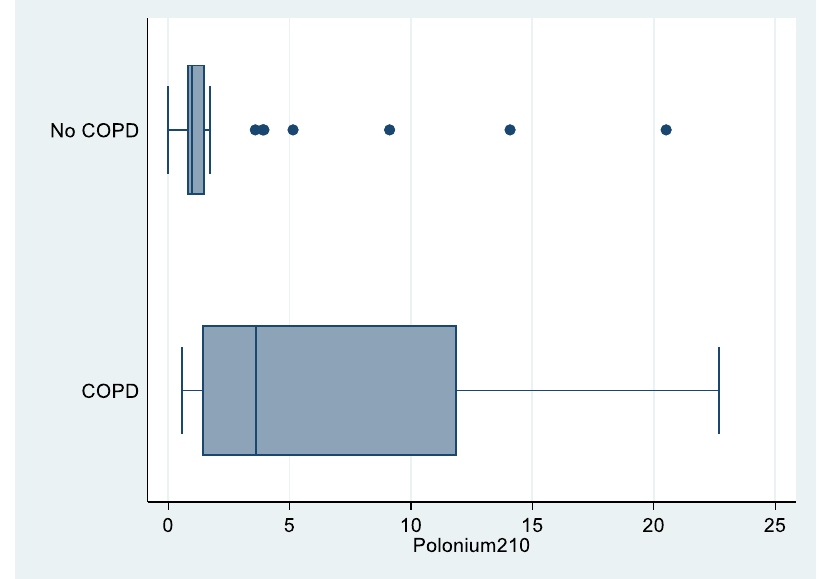
Figure 2. Box plot of polonium-210 (in mBq) by COPD status, “Polonium in vivo” study ( n = 49; 21 missing; COPD n = 12; no COPD n = 37). The left and right borders of the box are the lower and upper quartiles; the solid line in the box is the median. The “whiskers”, that is, the lower and upper adjacent values are used for identifying extreme values in the tails of the distribution. Dots greater than the upper adjacent value, represent outliers.